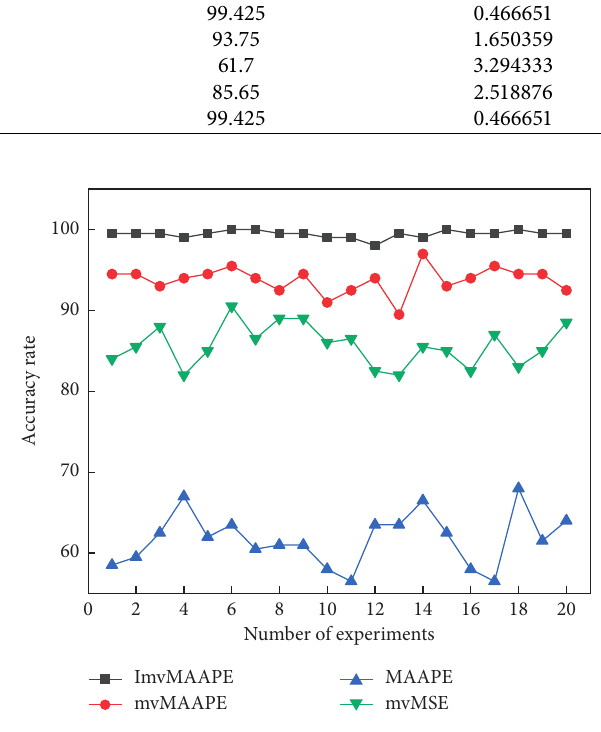
Figure 22: The bearing experiment results of different entropies.